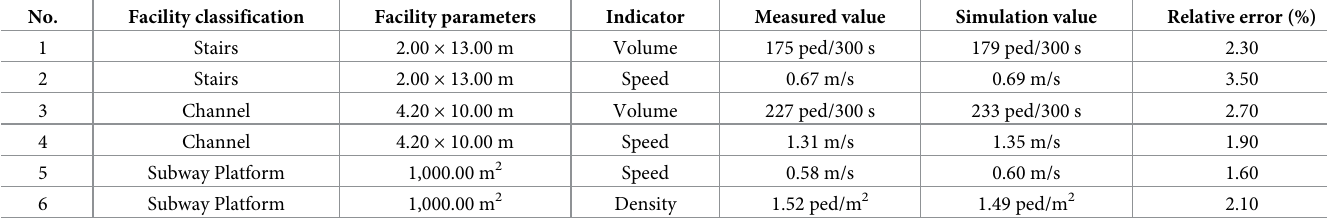
Table 6. Result of evaluation of parameter calibration.